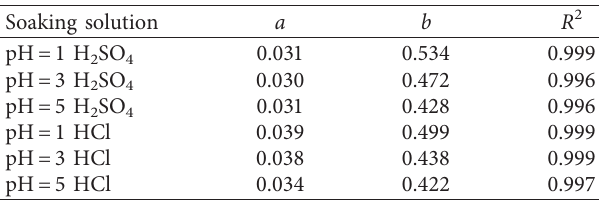
Table 7: Regression parameters of the relationship between the damage variables and soaking